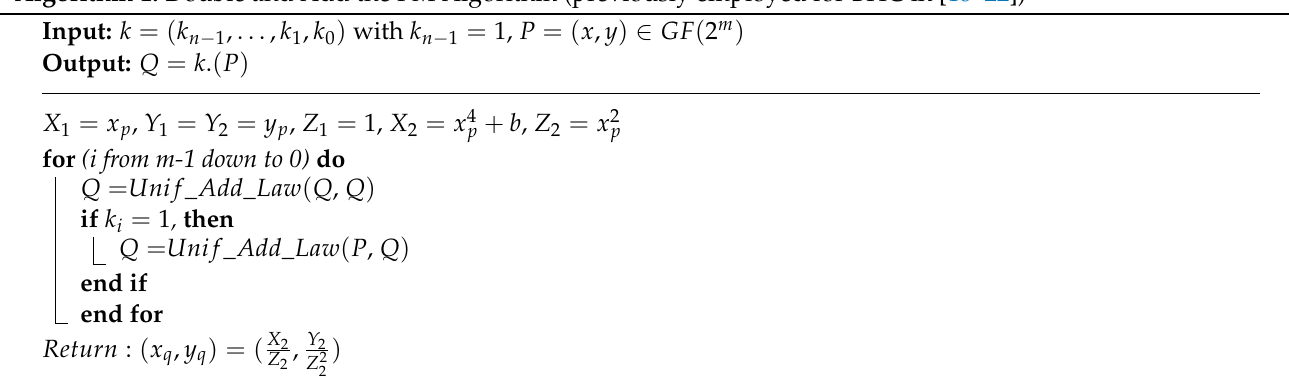
Algorithm 1: Double and Add the PM Algorithm (previously employed for BHC in [18–22]) Input: k = ( k n − 1 , . . . , k 1 , k 0 ) with k n − 1 = 1, P = ( x , y ) ∈ GF ( 2 m )